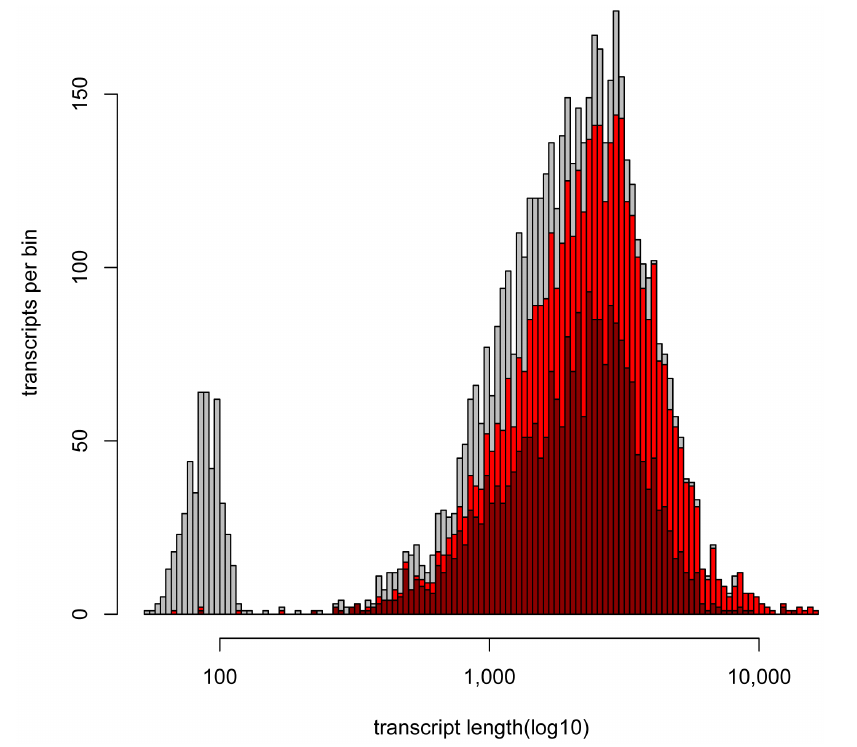
Figure 2. Broad coverage of existing chicken genes using long-read sequencing. Along the x-axis representing transcript length is a histogram of the number of RefSeq transcripts within a given range of lengths (grey). A similar histogram is shown for those transcripts that overlap each RefSeq annotation by any amount (red), or by more than 90% of the gene length (dark red).